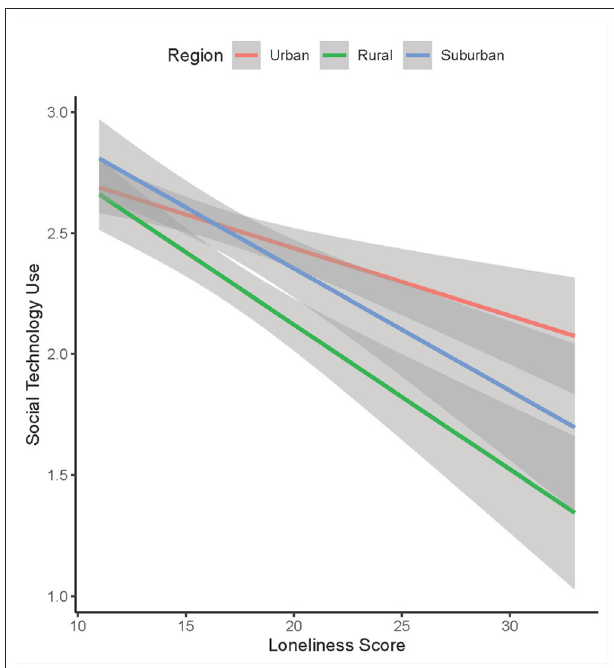
FIGURE 3 | Relationship between loneliness and social technology use by rurality. The magnitude of the negative relationship between loneliness and social technology use was stronger among rural older adults than urban older